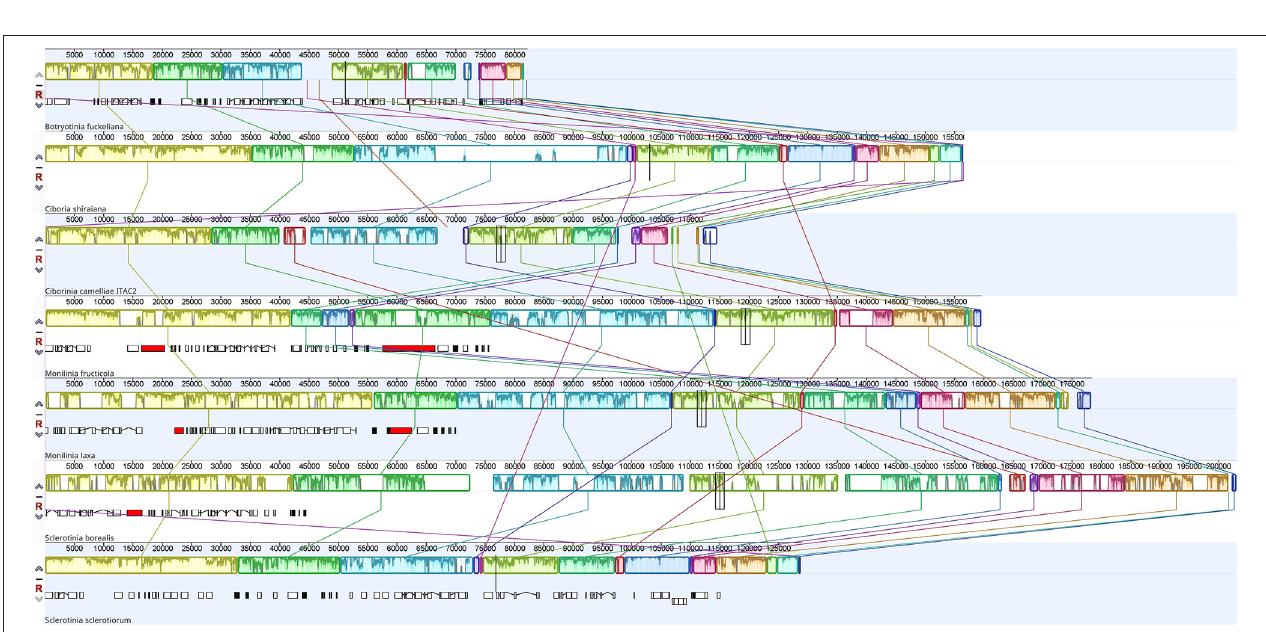
FIGURE 3 | Mauve alignment of Sclerotiniaceae mitochondrial genomes ( Botryotinia fuckeliana , Ciboria shiraiana, Ciborinia camelliae strain ITAC2, Monilinia fructicola, Monilinia laxa, Sclerotinia borealis and Sclerotinia sclerotiorum ). The alignment was performed setting nad4L gene as origin. The colored blocks reveal homologous regions between mitogenomes. Each block exhibits nucleotide similarity profile. Homologous sites are connected by lines.